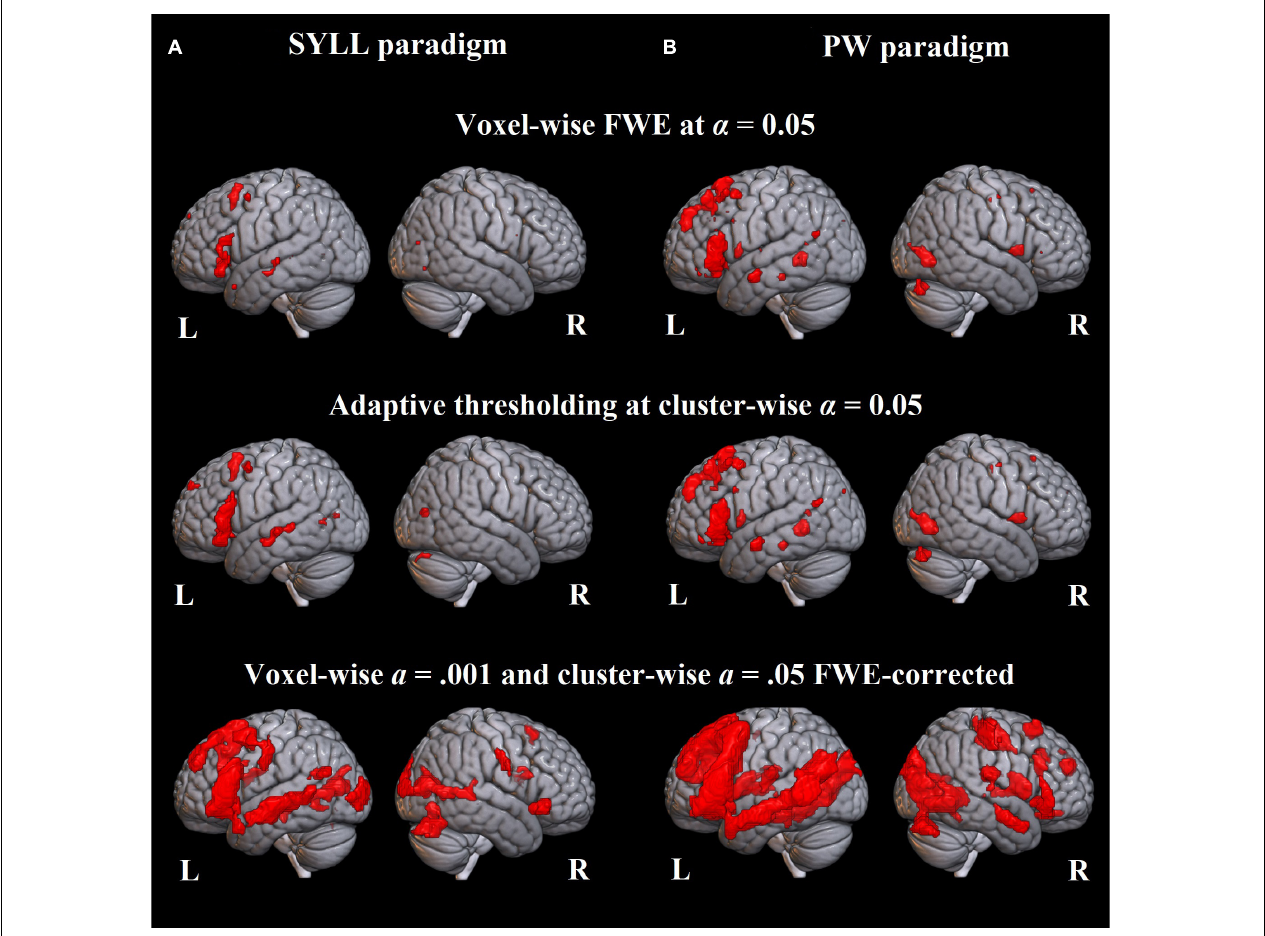
FIGURE 3 | Language-related activation significant at the group level. (A) Paradigm with the syllable baseline. (B) Paradigm with the pseudoword baseline. Top: FWE correction for multiple comparisons at α = 0.05, middle: adaptive thresholding (AT) as implemented in Gorgolewski et al. (2012) at α = 0.05, bottom: cluster correction at voxel-wise α = 0.001 and cluster-wise α = 0.05